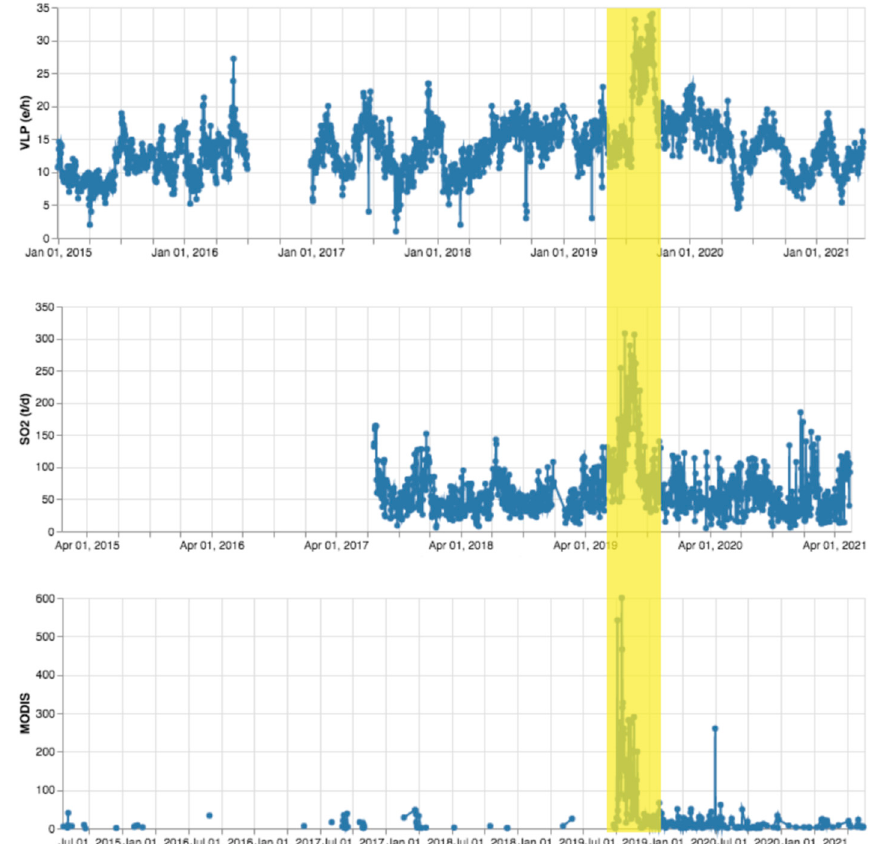
Figure 15. Time series of VLP, SO 2 flux and thermal anomalies (the latter expressed in MW) in 2015–2021 extracted from LGS daily bulletins.